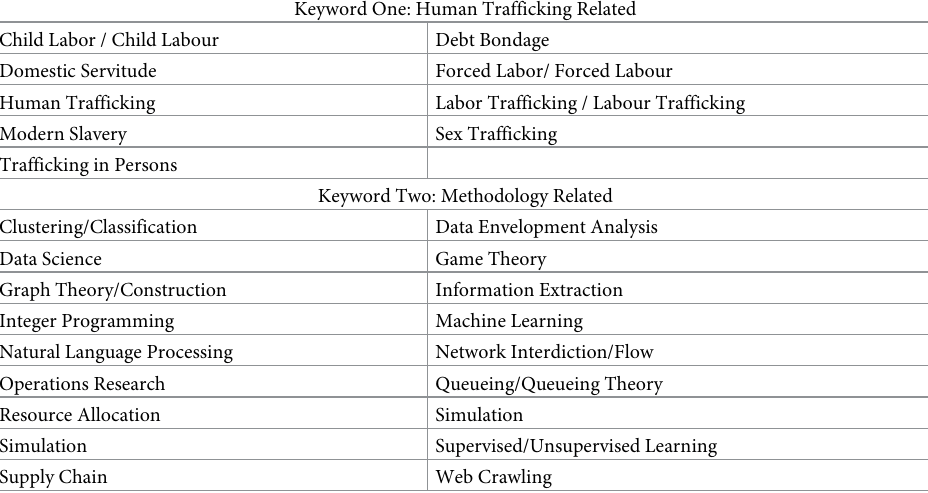
Table 1. Keywords used in search